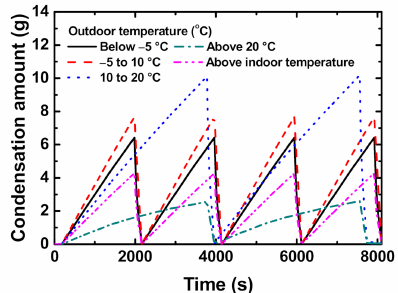
Figure 11. Condensation quantity over time when the proposed optimum ventilation and purge strategies are applied for the heat recovery